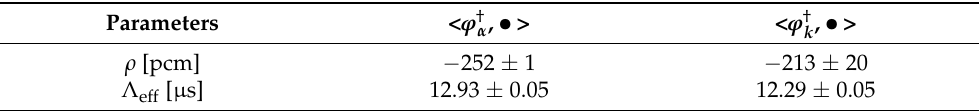
Table 15. Effective kinetics parameters of Problem III, super-critical configuration without delayed contributions.